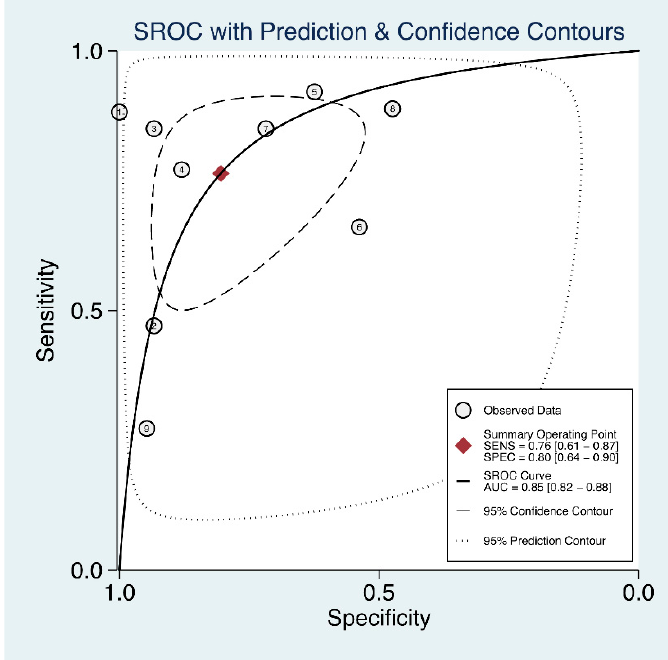
Figure 5. Receiver operating characteristic curves showing the performance of the sACE for diagnosing active sarcoidosis.